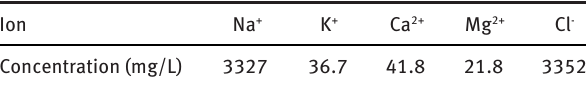
Table 1: Ionic composition of